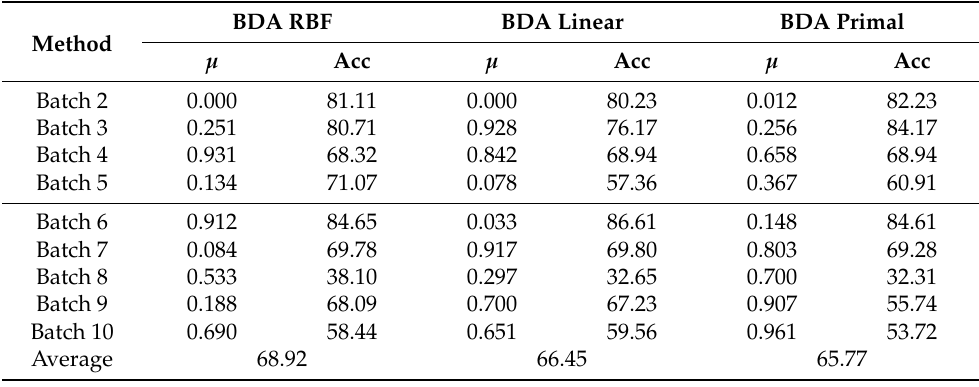
Table 3. The optimal weight balance factor and accuracy of the BDA drift compensation method for Setting 1.